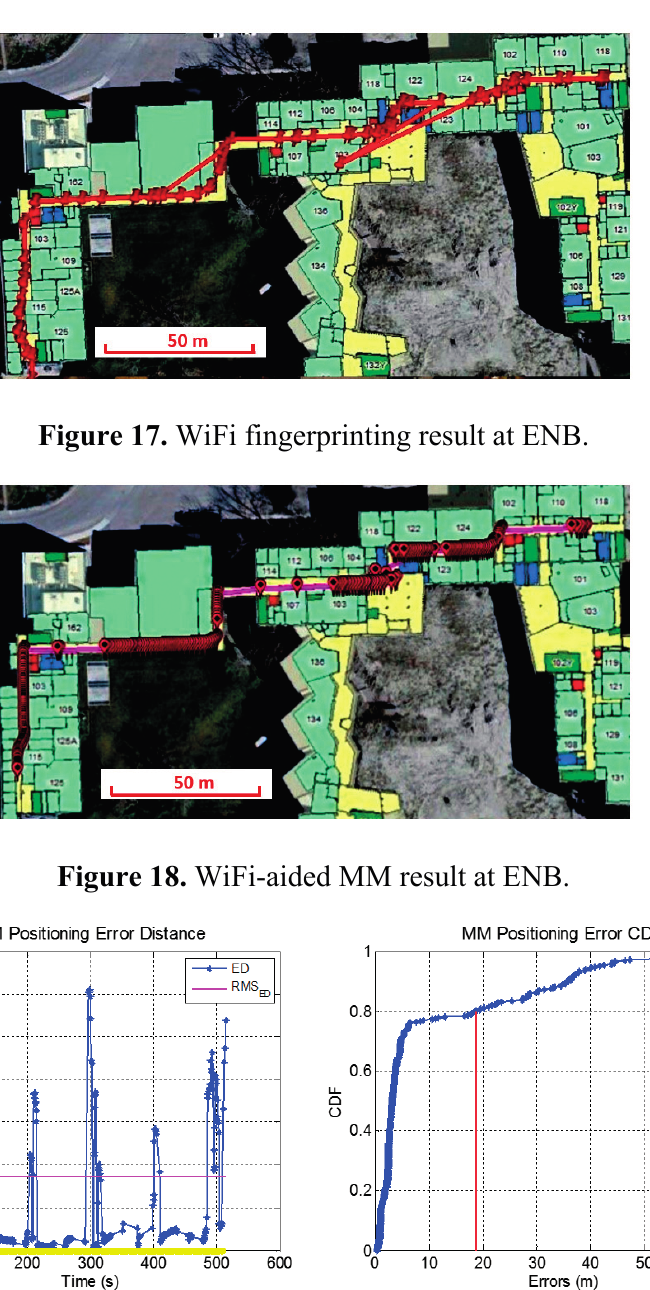
Figure 16. MM result at ENB.